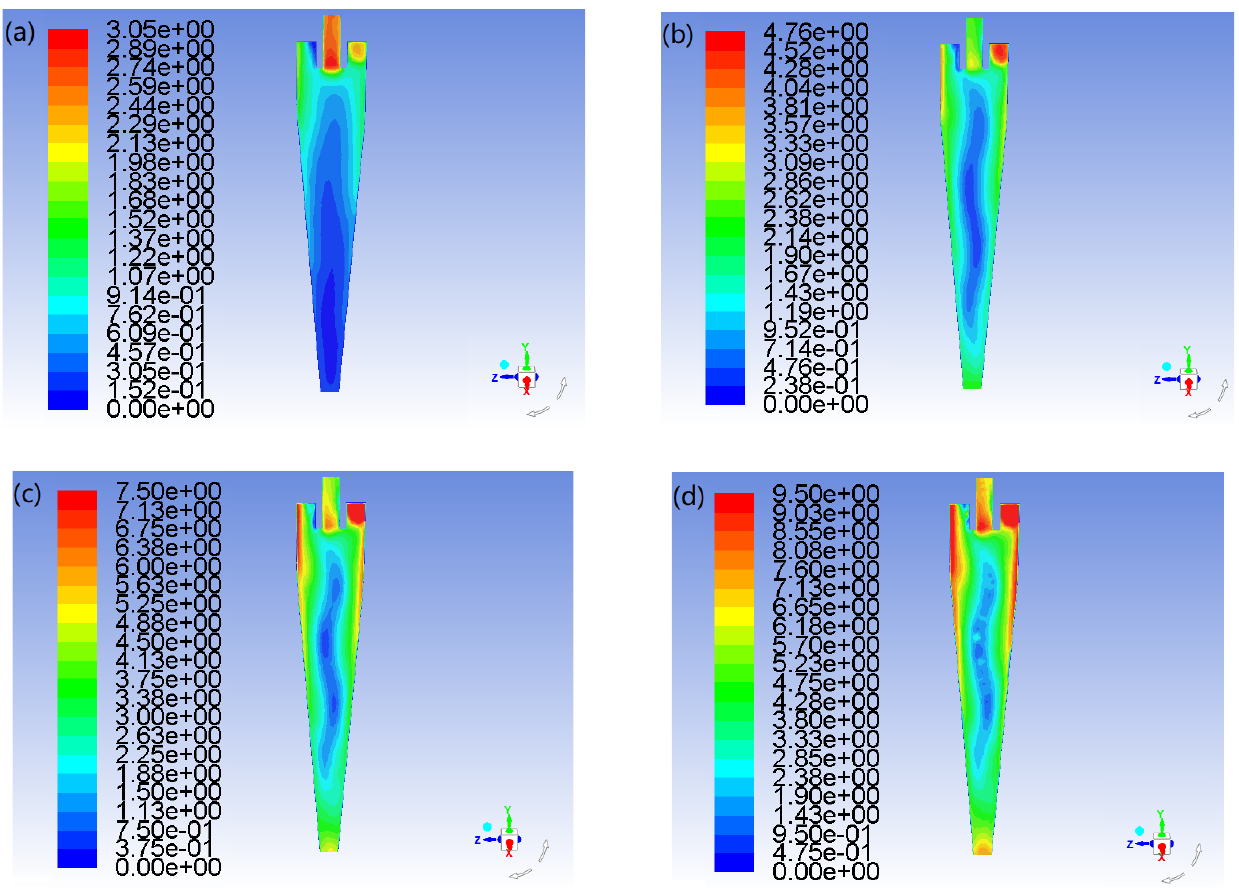
Figure 3. The velocity nephogram of tar vapor under different inlet velocities: ( a ) 2.0 m/s, ( b ) 4.0 m/s, ( c ) 8.0 m/s, and ( d ) 12.0 m/s.